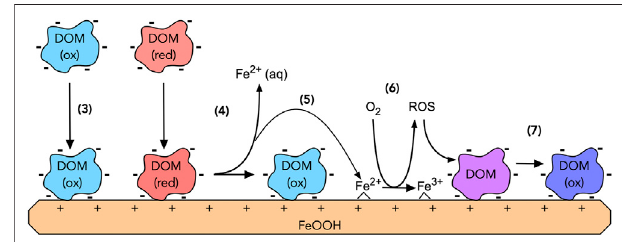
FIGURE 10 | Conceptual fi gure describing possible adsorption and redox reactions between DOM and an iron oxide. The numbers refer to the reactions in the text